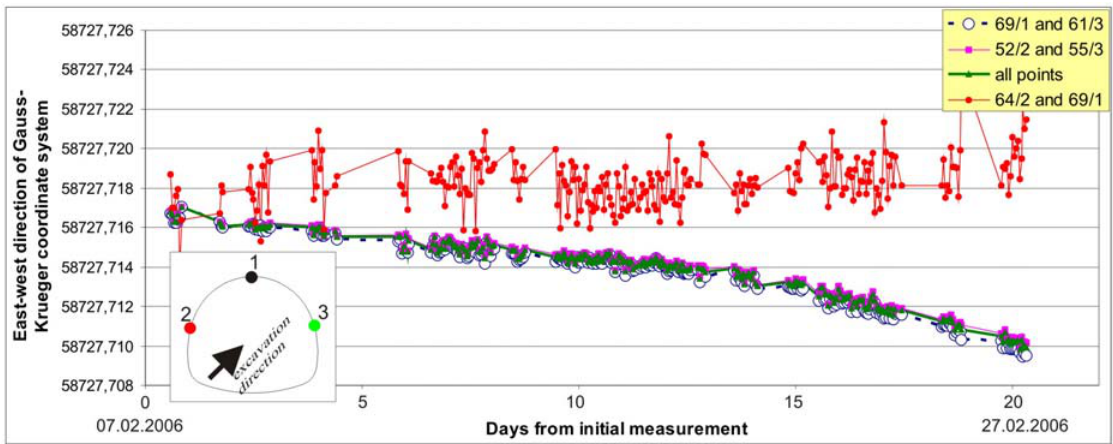
Figure 11. Movement of the position of the control station CS8 in east-west direction of Gauss-Krueger coordinate system as calculated from different combinations of the reference